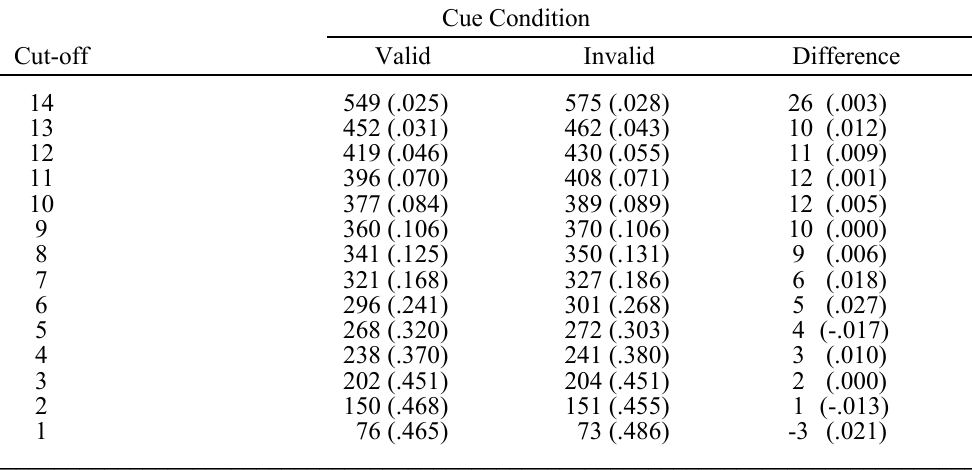
Mean Response Times (ms) and Error Rates (in Brackets) Across Equal-Sized Intervals of the Ranked RT Data in Experiment 1 (Each Cell Contains 100 Trials)